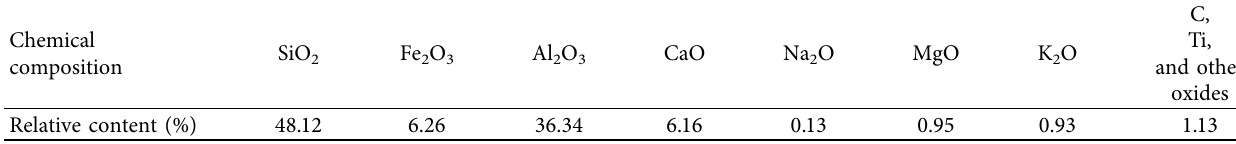
Table 3: Relative content of chemical composition of coal gangue.